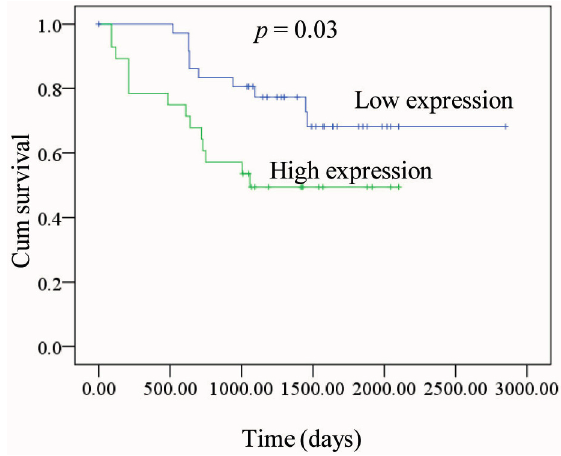
Figure 2. Kaplan-Meier recurrence-free survival curve according to PKM2 expression in patients with lung adenocarcinoma. A total of 65 clinical human lung adenocarcinomas cases were subjected to immunohistochemical analyses with anti-PKM2 antibody. The survival time of PKM2-negative patients is significantly longer than that of PKM2-positive